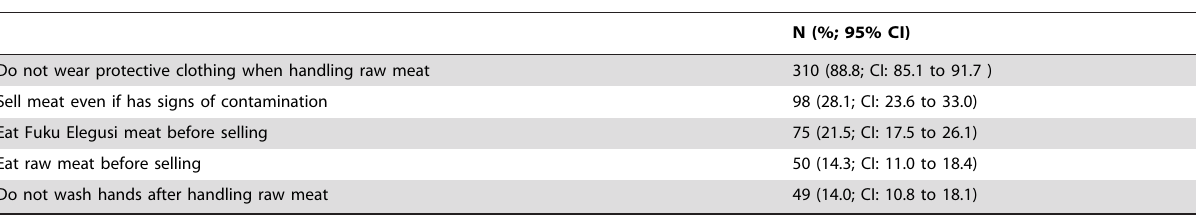
Table 1. Prevalence of high risk behaviours (n =349).